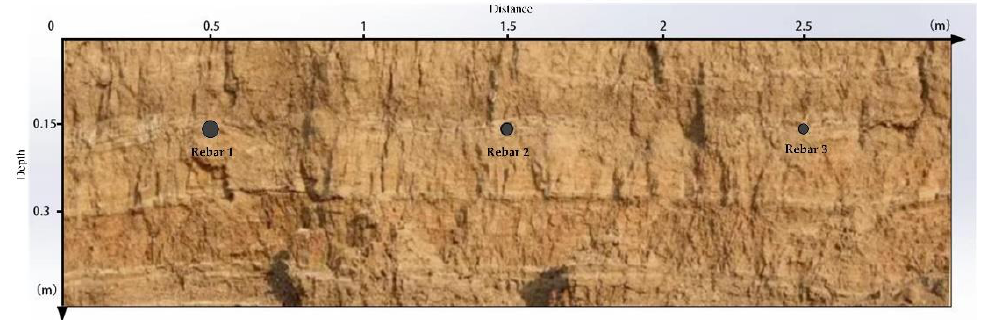
Figure 8. Test diagram of indoor real-time detection of steel bars.